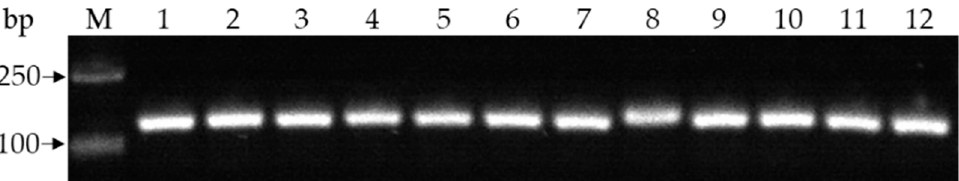
Figure 2. Detection of some isolates by using specific primers Fef1F/Fef2R for Fusarium oxysporum . M: DNA marker; 1–12: Fusarium oxysporum -like isolates from pea Fusarium wilt plants.